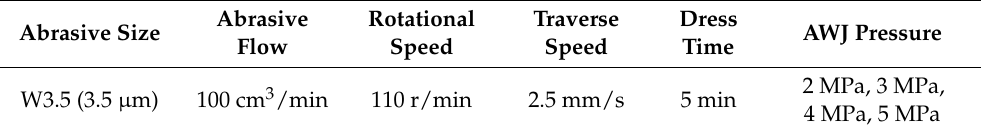
Table 1. Process parameters of AWJ dressing test.